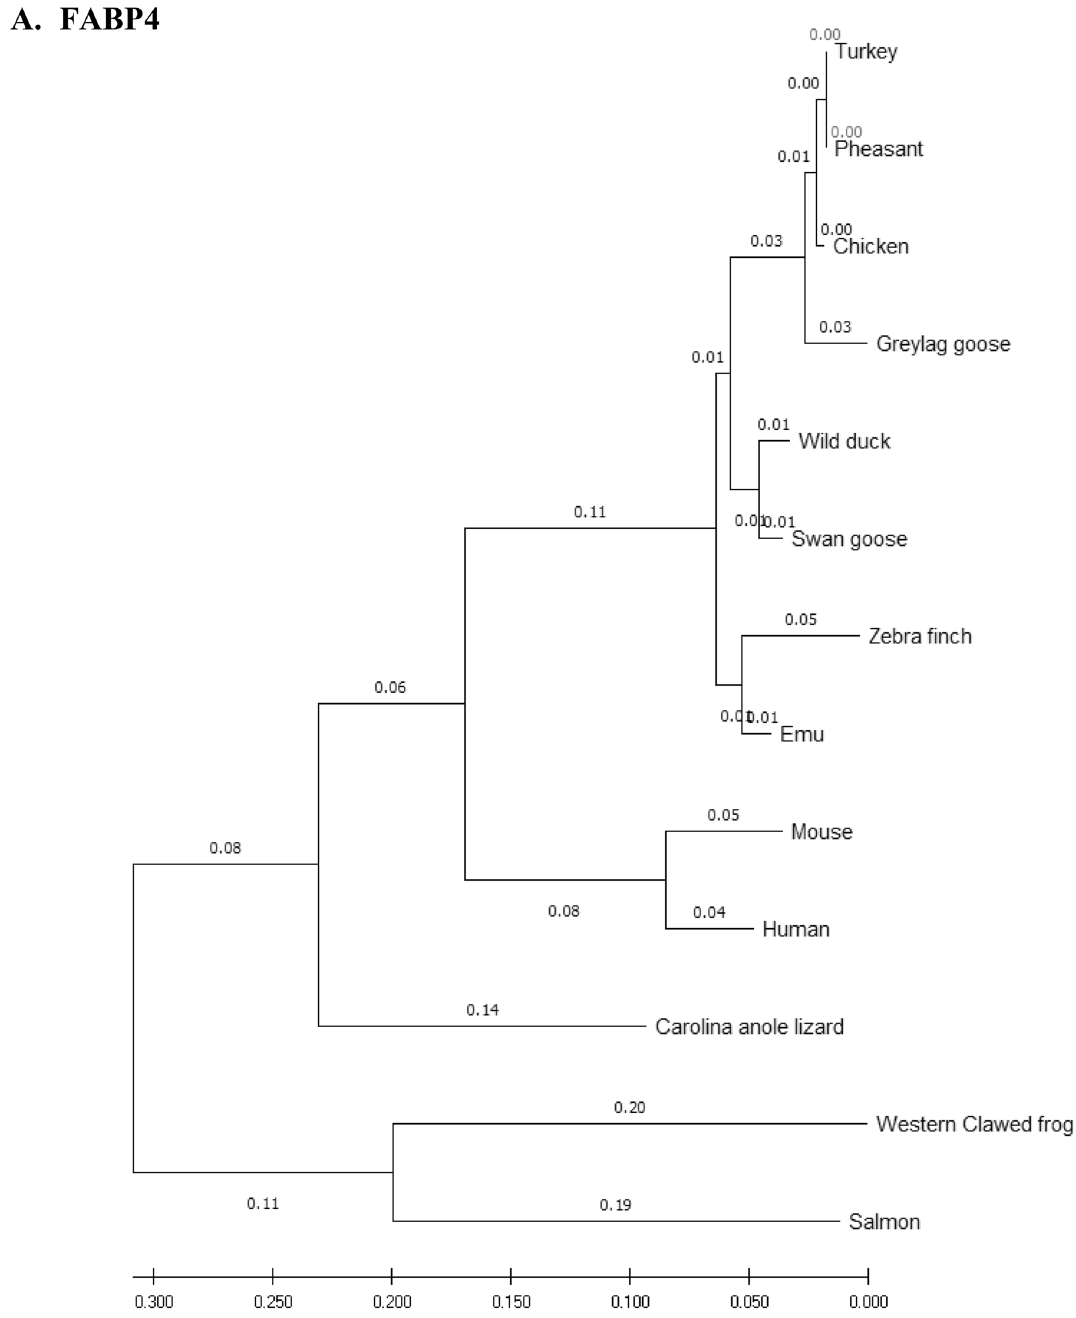
Figure 1. Phylogenetic relationship of emu amino acid sequences with 12 other species: D. novaehollandiae (emu, AET74082.1), Anas platyrhynchos (wild mallard duck, ABC96712.2), Anser anser (greylag goose, AAL79836.1), Anser cygnoides (swan goose, XP_013028005.1), Taeniopygia guttata (zebra finch, XP_002199746.1), Gallus gallus domesticus (chicken, AAL30743.1), Meleagris gallopavo (turkey, XP_003205187.1), Phasianus colchicus (pheasant, XP_031446733.1), Homo sapiens (human, NP_001433.1), Mus musculus (mouse, EDL05171.1), Salmo salar (salmon, AGH92578.1), Anolis carolinensis (Carolina anole lizard, XP_003219598.1), Xenopus tropicalis (Western clawed frog, NP_001015823.1). Phylogenetic trees developed using the neighbour-joining method. The numbers in the phylogram nodes indicate percent bootstrap support for the phylogeny. ( A ) FABP4. ( B ) SCD1. ( C ) LepR. ( D ) AdipoQ. ( E ) AdipoR1. ( F )